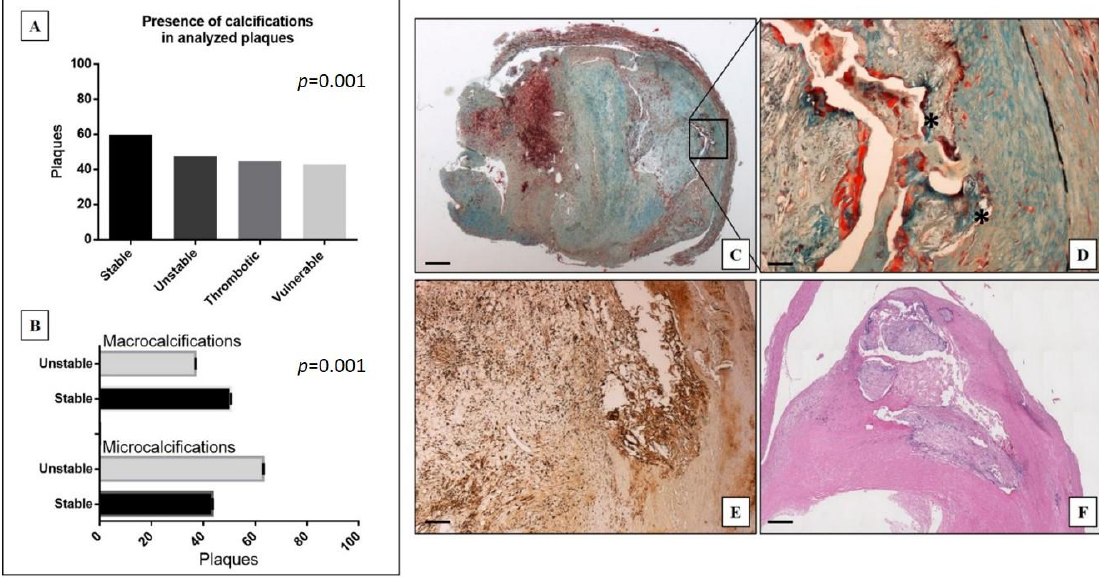
Figure 1. Distribution and morphological analysis of calcifications in carotid plaques. ( A ) Graph shows the presence of calcifications in stable, unstable, thrombotic, and vulnerable plaques. ( B ) Graph displays the presence of micro or macrocalcification in stable and unstable plaques. ( C ) Movat staining shows the presence of microcalcifications in an unstable atheromatous plaque with acute thrombosis in organization. Square indicate the area enlarged in panel D (scale bar represents 500 µ m). ( D ) A magnification of microcalcification reported in panel C (scale bar represents 50 µ m). ( E ) Immunohistochemical staining shows numerous CD163 positive M2 macrophages in the thrombotic atheromatous plaque reported in panel C (scale bar represents 100 µ m). ( F ) Hematoxylin and Eosin staining of a stable carotid plaque with macrocalcification, constituted mainly by fibrous tissue (scale bar represents 500 µ